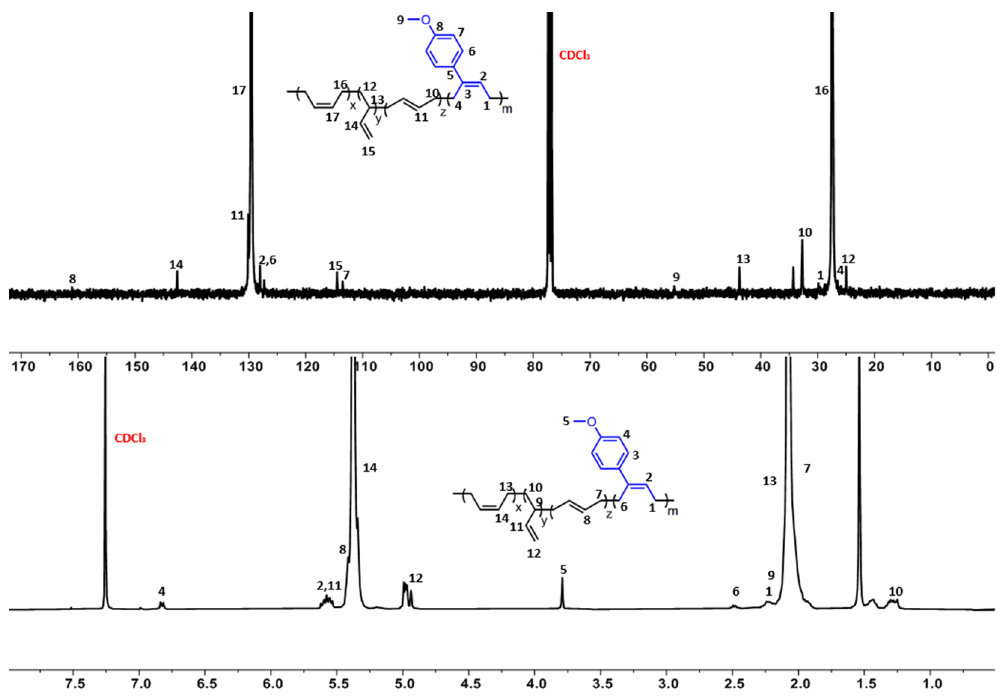
Figure 5. The 1 H and 13 C NMR spectra of poly(2-MOPB- co -BD) from entry 4, Table 2.